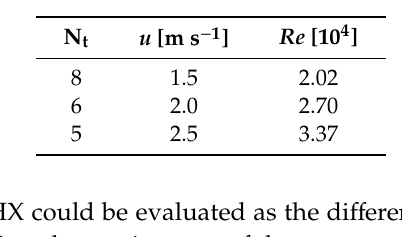
Table 1. Reynolds number and numbers of tubes in parallel configuration evaluated for each air